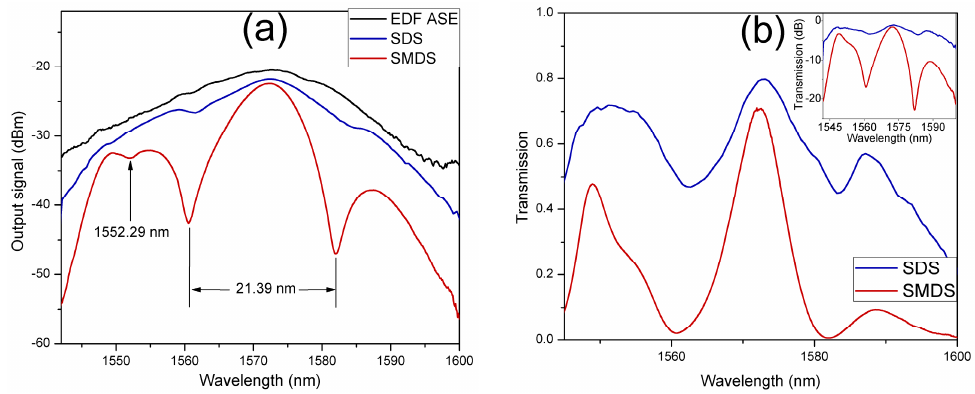
Figure 3. ( a ) Measured output signal of the ASE source, SDS and SMDS in-fiber structures; ( b ) transmission spectral response of the SDS and the SMDS in-fiber interferometers. ( b ) transmission spectral response of the SDS and the SMDS in-fiber